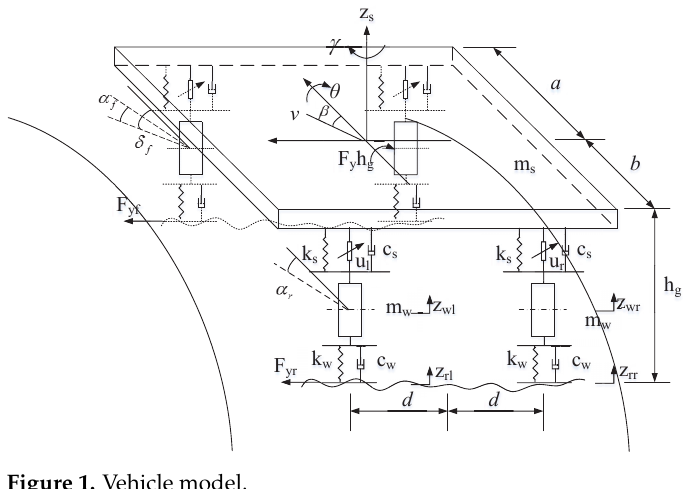
Figure 1. Vehicle